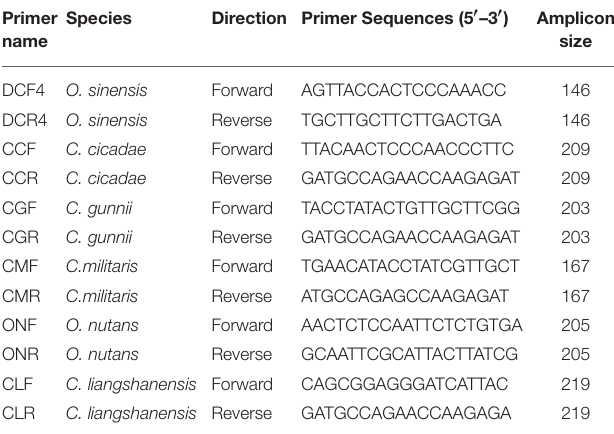
TABLE 2 | Primers of O. sinensis and its counterfeits used for PCR